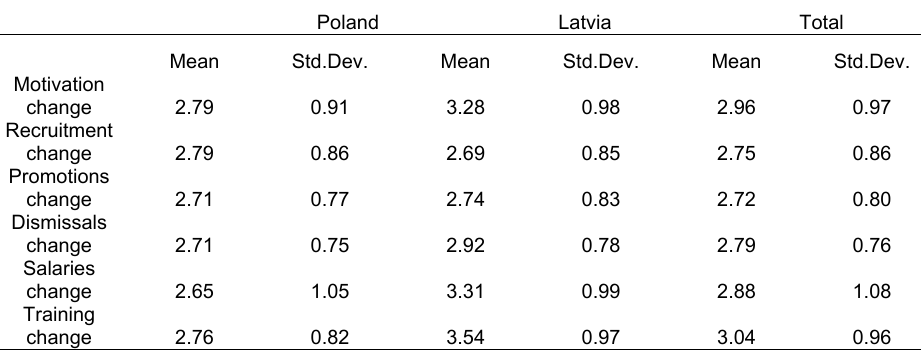
Table 1. Descriptive